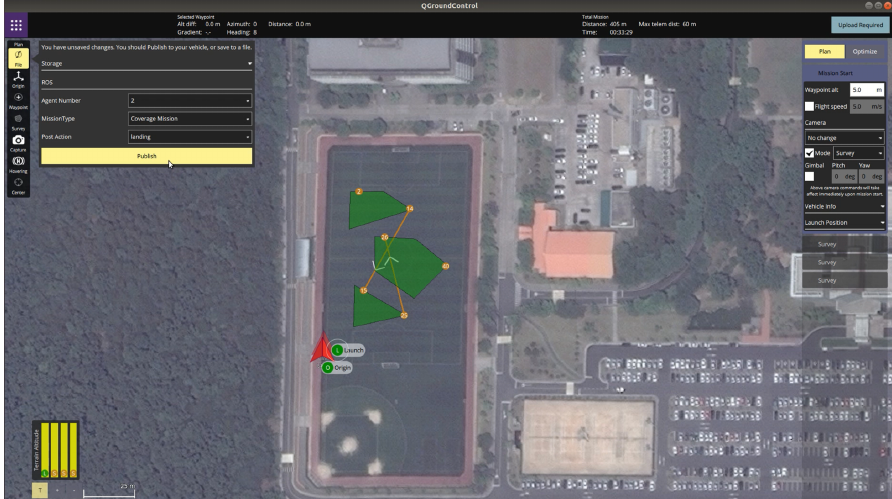
Figure 12. Mission plans through QGroundControl.